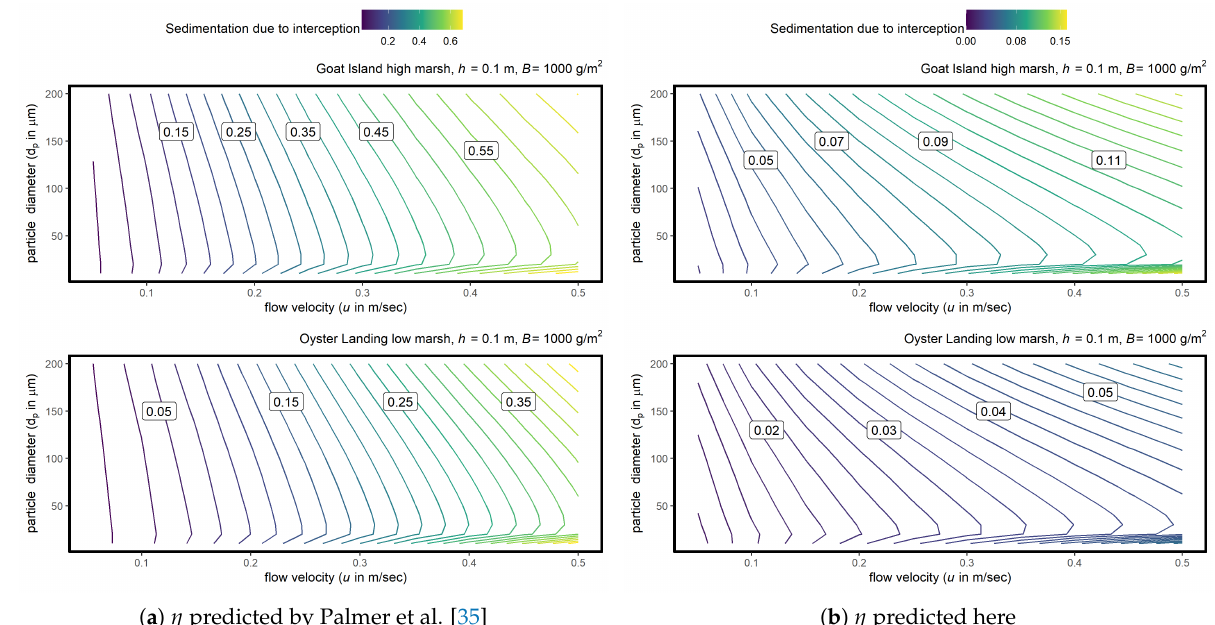
Figure 4. Fraction of sedimentation due to particle interception (Q c /[Q c + Q s ]) using the form for η from ( a ) the Palmer et al. [35] model and ( b ) the proposed method (Equation (8) for the North Inlet Estuary, South Carolina (data from Mudd et al. [3]). High marsh refers to a site with higher estimated vegetation density ( a = 0.087 cm − 1 ), and low marsh refers to a site with lower estimated vegetation density ( a = 0.047 cm − 1 ). Our model predicted less particle interception (0–16% compared with 2–74% in the Palmer et al. formulation) and less total sedimentation (8.46 × 10 2 –4.82 × 10 5 vs. 1.31 × 10 3 –1.28 × 10 6 g cm − 2 s − 1 ), although both estimated that particle interception would be greatest in systems with small